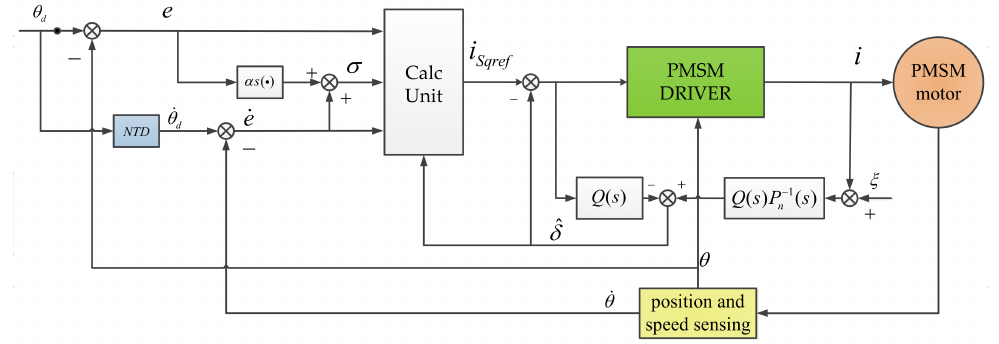
Figure 6. Robust sliding mode controller based on rapid NTD and